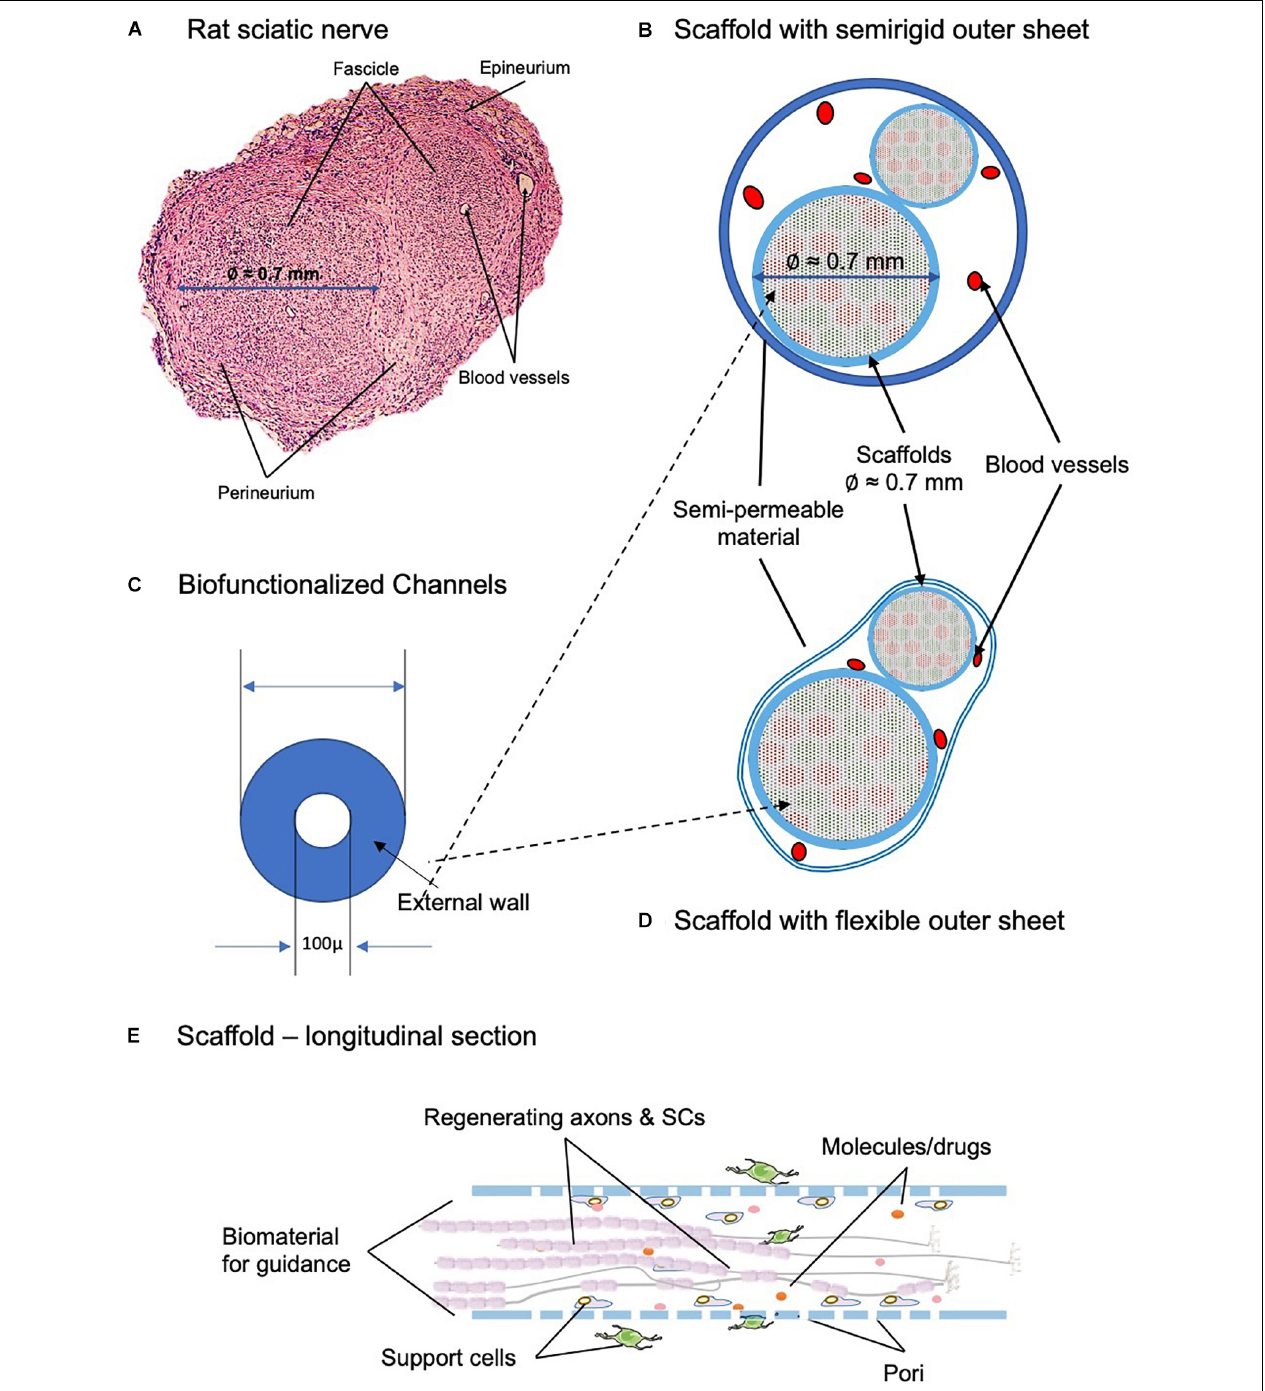
FIGURE 6 | Desired biomimetic devices and scaffolds for neurotrophic biomolecules to be implemented in a future PNI-repair scaffold. (A) Transversal section of the rat sciatic nerve, with two fascicles and the different layers of connective tissue that organize the anatomy of the nerve. The differences on size between the fascicles can be observed. (B,D) Transversal section showing the 3D scaffold architecture, oriented to sensory–motor–guided regeneration; channels for sensory axons are in green, and motor in red. Scaffold of Ø 1.5 to 2.0 mm. The outer sheet can be both semirigid (B) or flexible (D) , depending on the area of the implant and the characteristics of the surrounding tissue that defines the most adequate option. (C) Magnification of the biofunctionalized channel. Channels of Ø 100 µ m for the guidance of individual axons, sensory or motor ones. (E) Longitudinal section of the scaffold representing both the physical and chemical cues that determine the regeneration of the sectioned axons. The biomaterial provides the neurons with supporting cells, such as Schwann cells (SCs), molecules, and drugs. Furthermore, it acts as a substrate for the attachment of the growing axons.